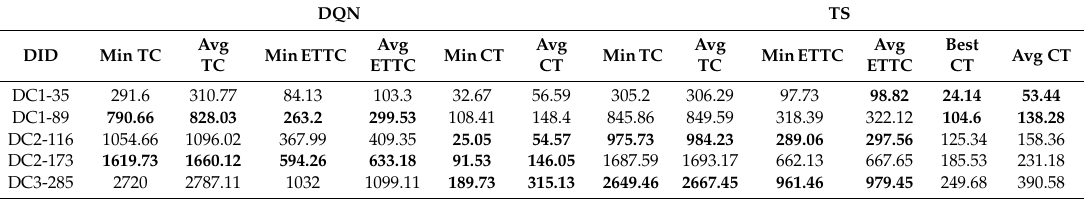
Table 9. Performance comparison between DQN and TS.